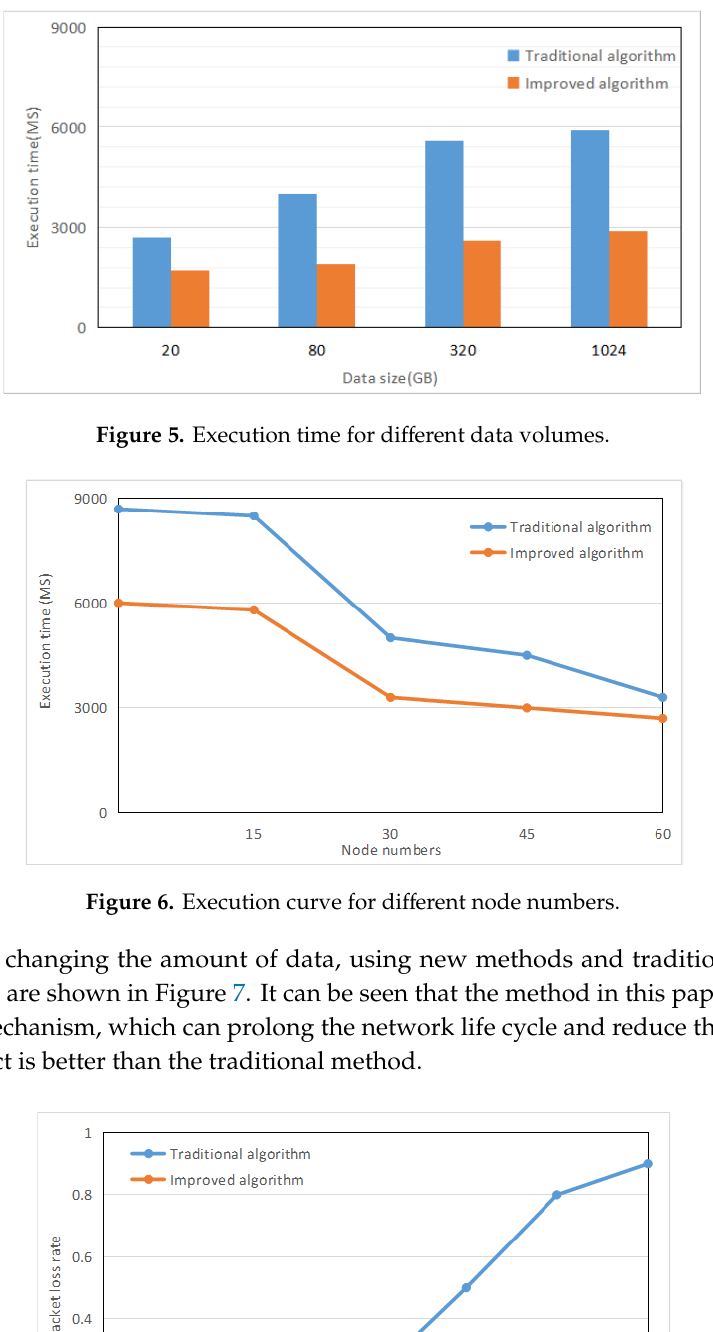
10 of 14 Table 1. Parameter settings of the corresponding genetic algorithm. Parameter